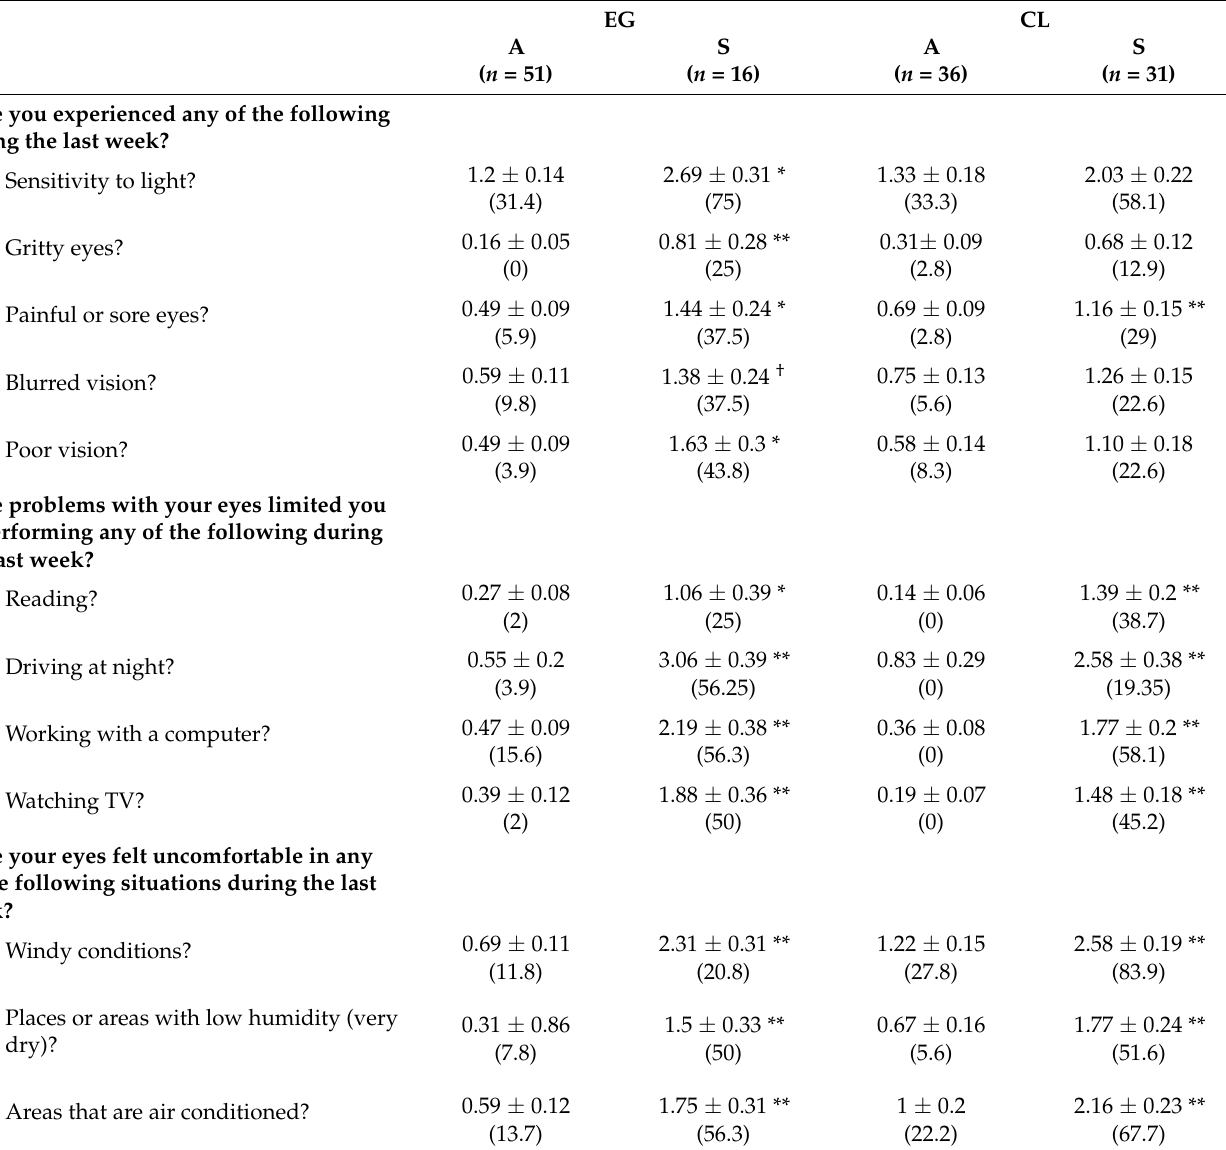
Table 3. Scores of OSDI questions obtained in asymptomatic (A) and symptomatic (S) eyeglasses (EG) and contact lens (CL)